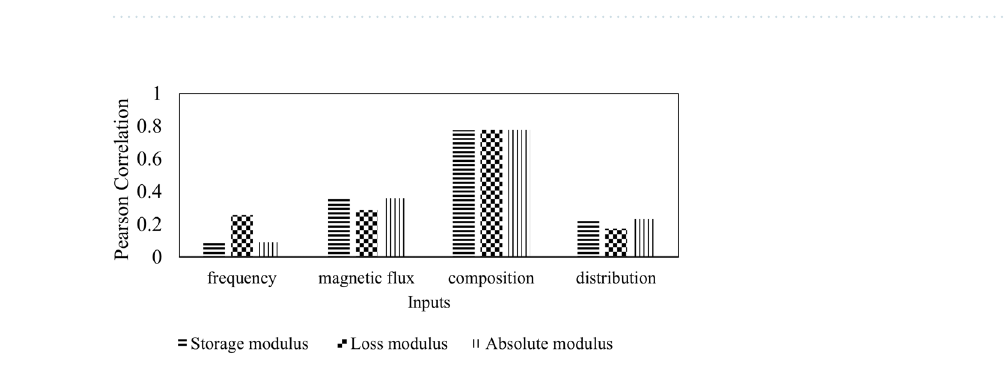
Table 4. The correlation between input variables.